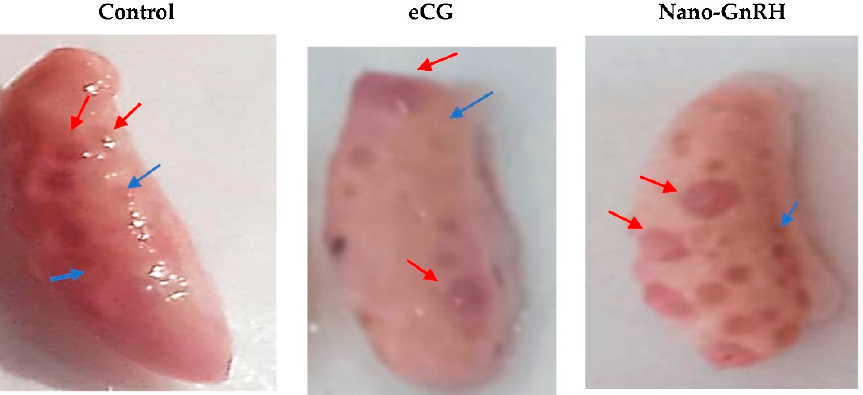
Figure 2. Two-days ovulation points (red arrows) and growing follicles (blue arrows) in ovaries of control rabbits or those treated with 25 IU equine chorionic gonadotropin (eCG) or 0.2 μ gonadotropin-releasing hormone (GnRH)-chitosan- tripolyphosphate (TPP) nanoparticles. Higher numbers of growing follicles and ovulation points and larger diameters of ovulation points could be observed in GnRH-chitosan-TPP nanoparticles (unpublished data).